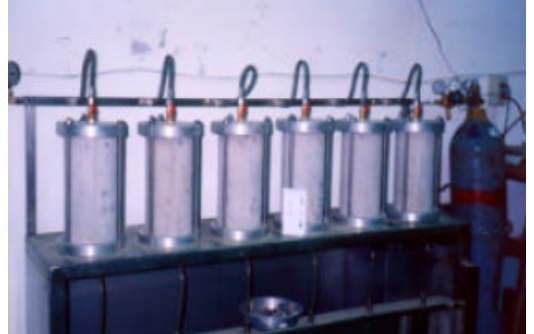
Figure 3. Permeability test.